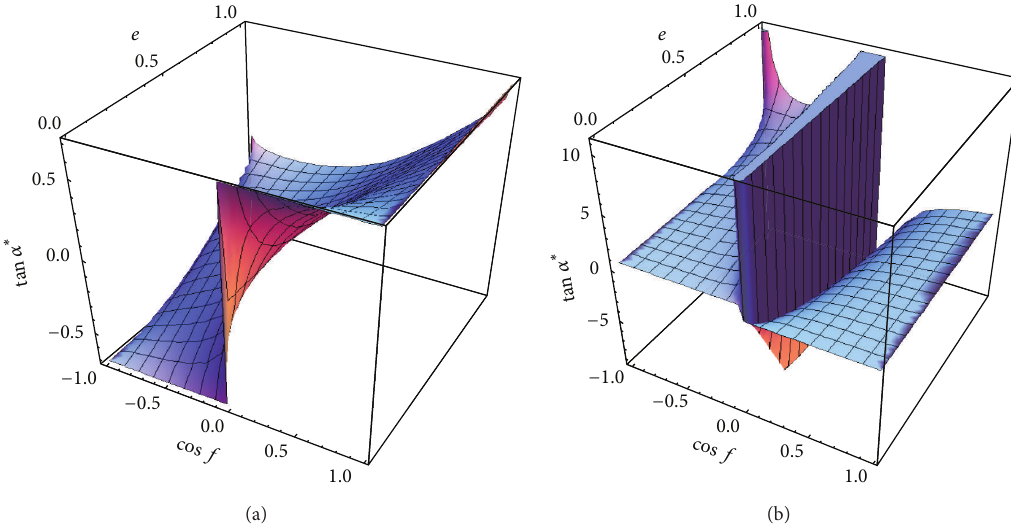
Figure 3: (a) The optimum cone angle that maximizes the rate of change of semimajor axis when taking the positive sign in the numerator. (b) The optimum cone angle that maximizes the rate of change of semimajor axis when taking the negative sign in the